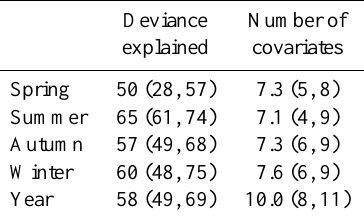
Table 3. Deviance explained (%) and number of covariates aver- aged over all stations for each season. Numbers in parentheses in- dicate the minimum and the